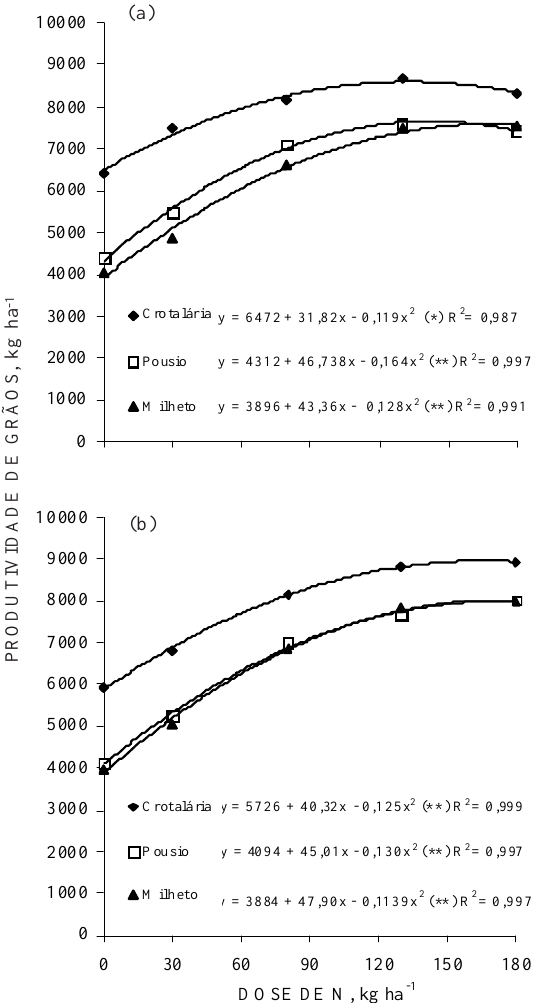
Figura 2. Produtividade de grãos de milho, considerando as doses de N e sistemas de cobertura do solo, anos agrícolas 2001/02 (a) e 2002/03 (b). (Obs. * e **: Significativos a 5 e 1 % pelo teste F,